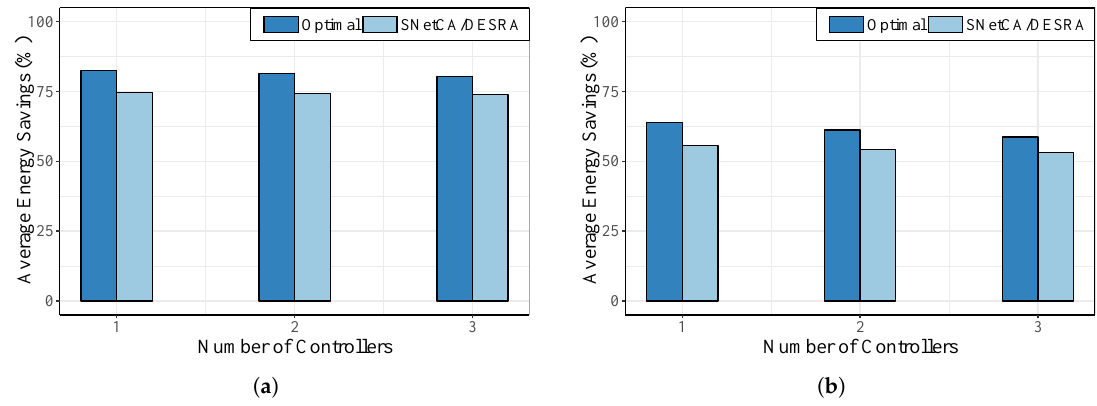
Figure 2. Average energy savings comparison between optimal and heuristic solutions for different numbers of controllers in: ( a ) New York topology and ( b ) Geant topology.